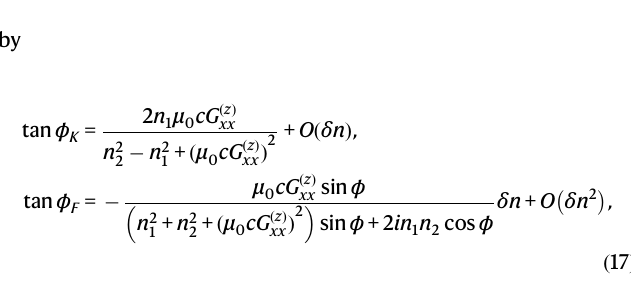
Þ in general, c σ s 0 xy